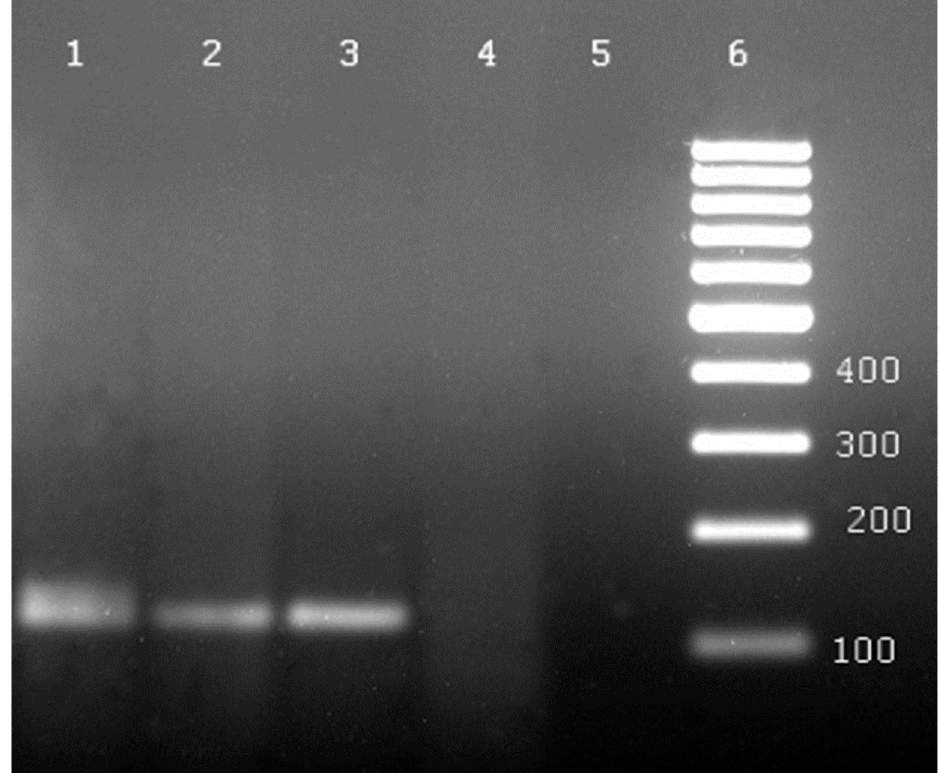
Figure 7. Amplification profiles generated by SCAR marker ACC/CCC 172 (117 bp) linked with the TSWV resistance gene. Lanes: 1, N.mutabilis ; 2, N. alata ; 3, N. forgetiana ; 4, N.tabacum cv. VAM; 5, N. tabacum cv. Burley 21; 6, DNA ladder 100